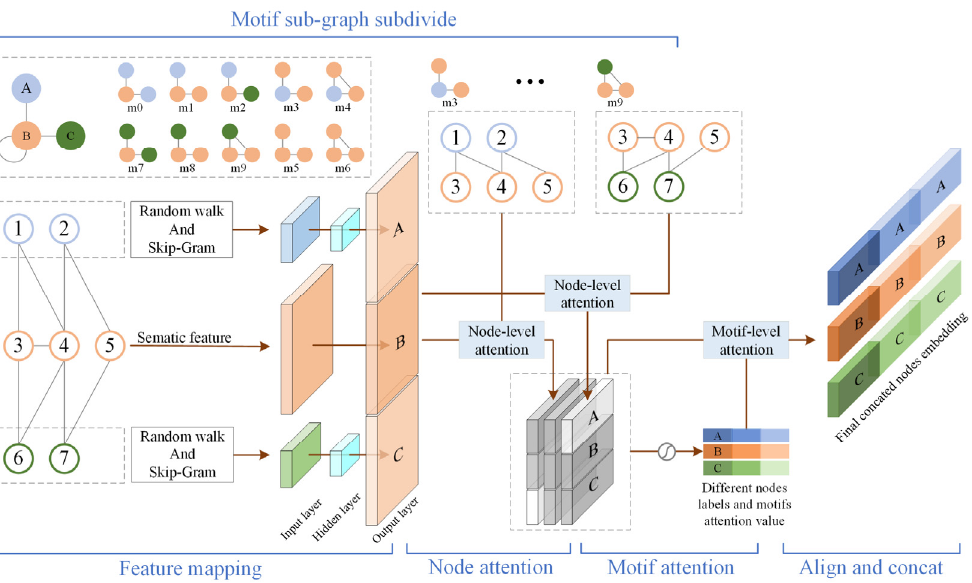
Figure 3. The MBHAN framework. The different colors in the heterogeneous graph represent different node types. The different colors in the hierarchical attention mechanism represent different levels of attention.